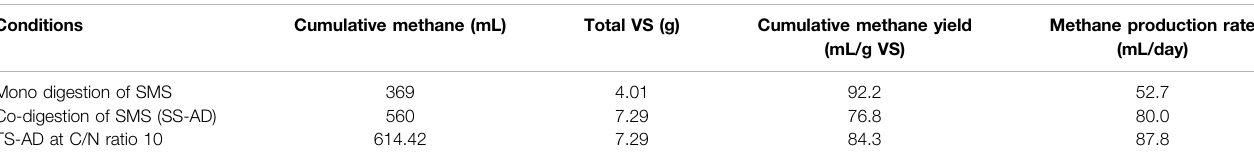
TABLE 6 | Kinetics of the digesters at different conditions.